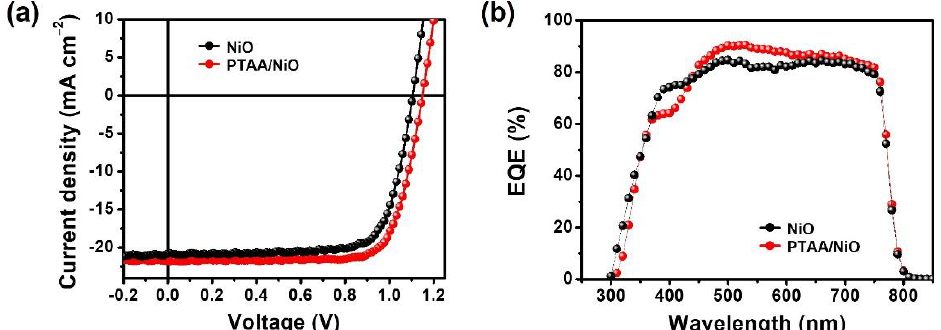
Figure 3. ( a ) J – V curves of the NiO and PTAA/NiO PSCs with active area of 1.12 cm 2 . ( b ) EQE spectra of NiO and PTAA/NiO based PSCs. Table 1. Device performance of the NiO monolayer and PTAA/NiO bilayer-based PSCs under AM 1.5 G illumination at 100 mW cm −2 .